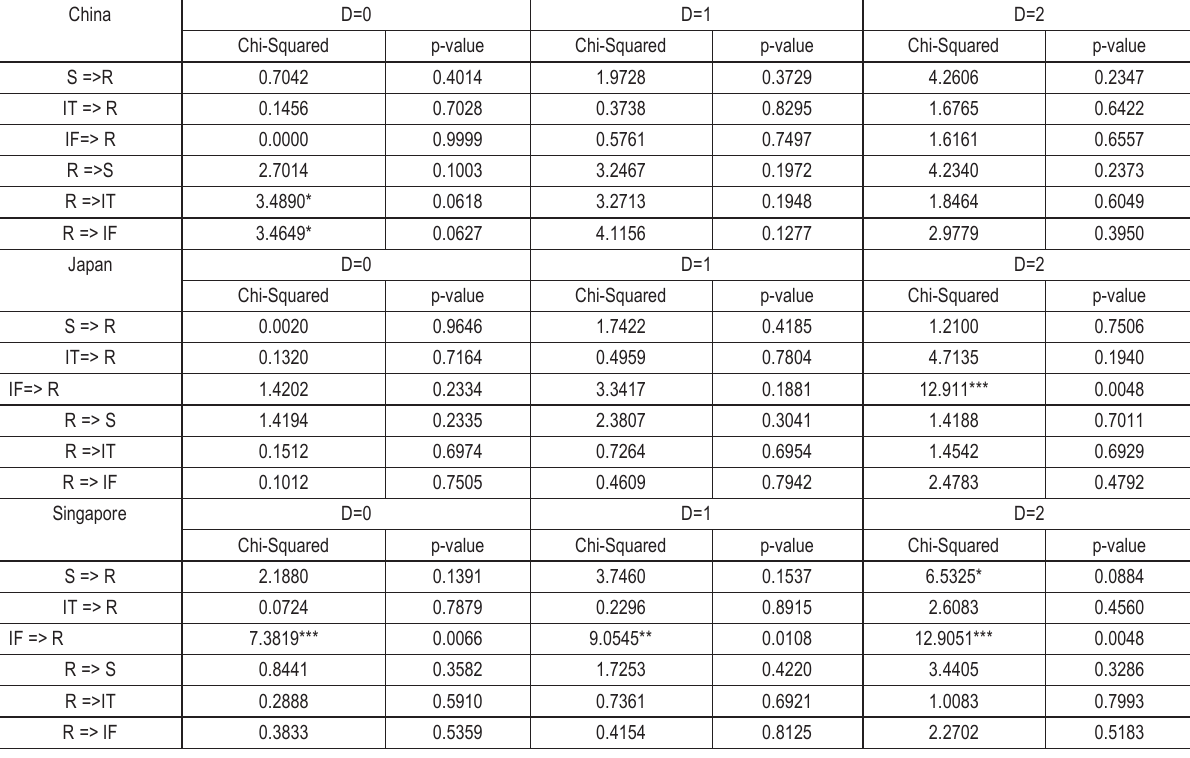
Table 6. The results of the Granger non-causality tests of Toda and Yamamoto